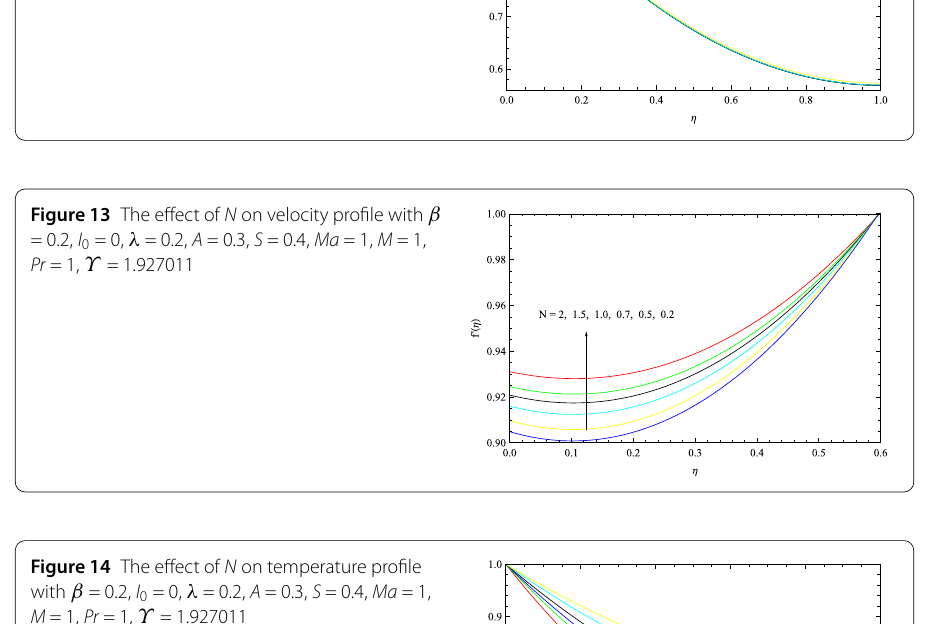
Figure 14 The effect of N on temperature profile with β = 0.2, I 0 = 0, λ = 0.2, A = 0.3, S = 0.4, Ma = 1, M = 1, Pr = 1, Υ = 1.927011